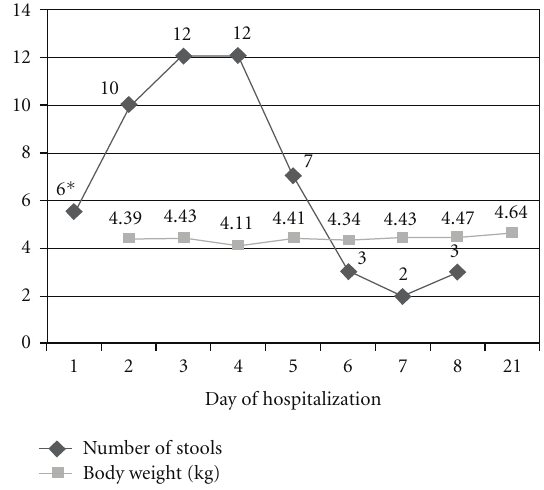
Figure 1: Evolution of both number of daily stools and baby’s body weight during hospitalization. Stool count on day one ( ∗ ) corresponds to the number of stools since the baby was admitted to hospital from midday on that